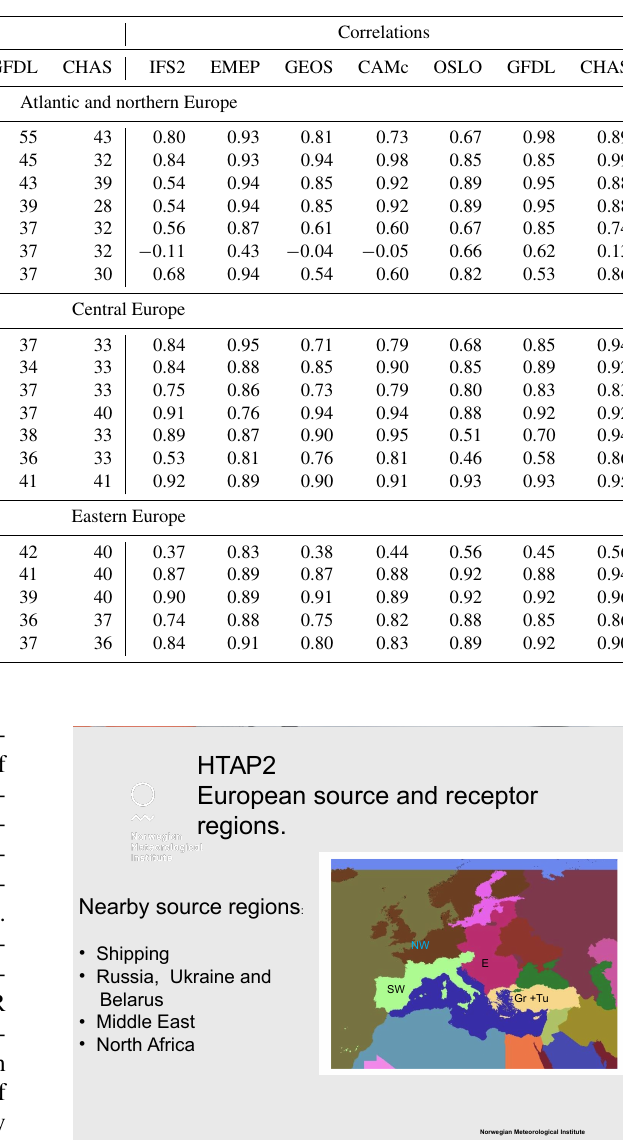
Table 2. Annual mean measured and model-calculated O 3 in ppb for the European O 3 GAW sites downloaded from http://ds.data.jma.go.jp/ gmd/wdcgg/ (last access: 21 September 2018). See also auxiliary material for figures. The comparison is based on monthly average model and measured data. Model IFS2 is IFS_v2, EMEP is EMEP_rv48, GEOS is GEOS-Chem, CAMC is CAMchem, OSLO is OsloCTM3_v2, GFDL is GFDL_AM3 and CHAS are the CHASER models (CHASER_t106/CHASER_re1). Obs. is the observation.